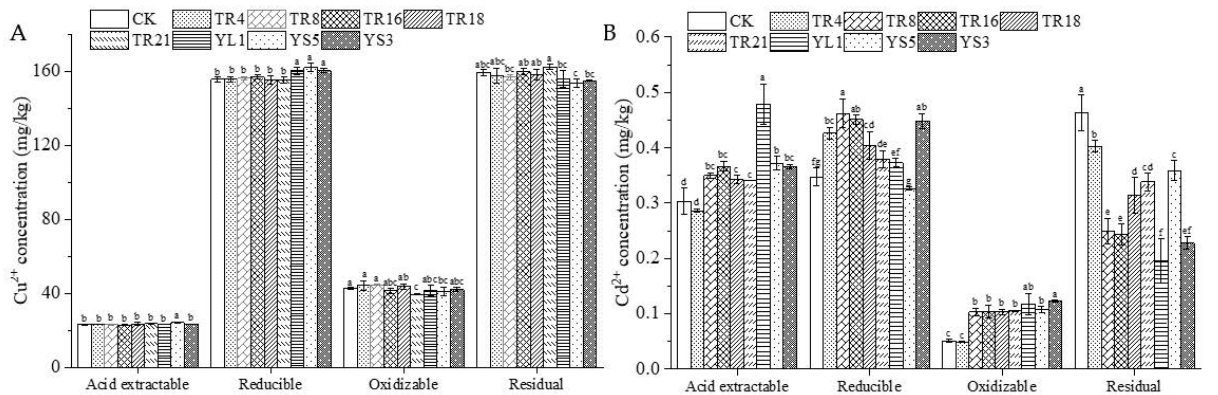
Figure 4. The chemical speciation of Cu ( A ) and Cd ( B ) in soil. The different lowercase letters in the figures indicate significant differences ( p < 0.05).